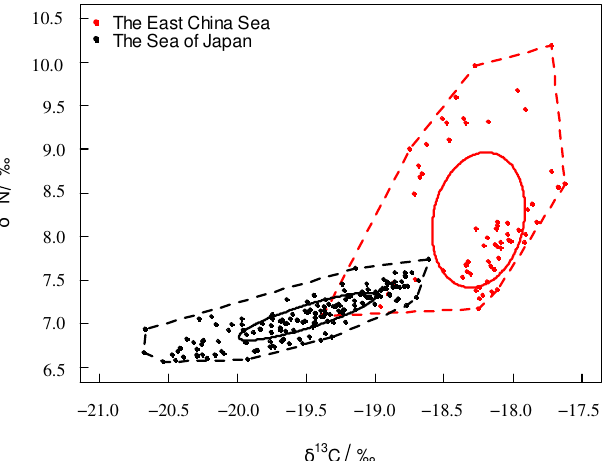
Figure 4. Trophic niche of T. pacificus collected in the different areas (square plot: TA; circle plot: SEAc). The trophic niche area (SEAc) of the females was larger than that of the males in both areas. For T. pacificus collected in the East China Sea, the SEAc of the females and males were 1.068‰ 2 and 0.48‰ 2 , respectively. The overlapping SEAc was 0.239‰ 2 between fe- males and males, and the overlapping rate was 18.3%. For T. pacificus collected in the Sea of Japan, the SEAc values of the females and males were 0.274‰ 2 and 0.139‰ 2 , respec- tively. The overlapping SEAc was large between females and males, the overlapping SEAc was 0.126‰ 2 , and the overlapping rate was 44.2% (Figure 5).